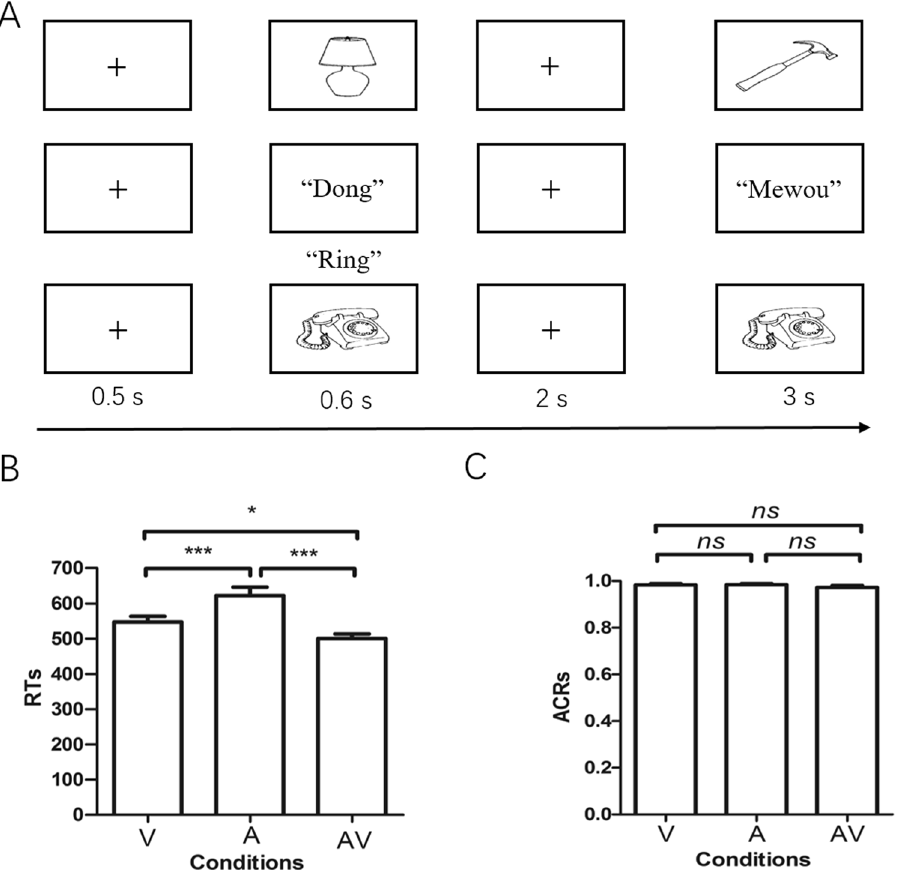
Figure 1. Behavioural data results. ( A ) Three-block design of the behavioural experiment. In each trial with three blocks, a fixation cross was shown for 0.5 s, and then a stimulus (visual, auditory, and congruent audiovisual) was presented, a blank screen was shown after a 2 s delay, and finally the test stimulus appeared within a 3 s time limit. ( B ) Corrected mean RTs for memory retrieval during the three conditions. ( C ) Mean ACRs for memory recognition in the three blocks. Error bars represent the standard error of the mean. Note: * p < 0.05, *** p < 0.001. ns , no significant